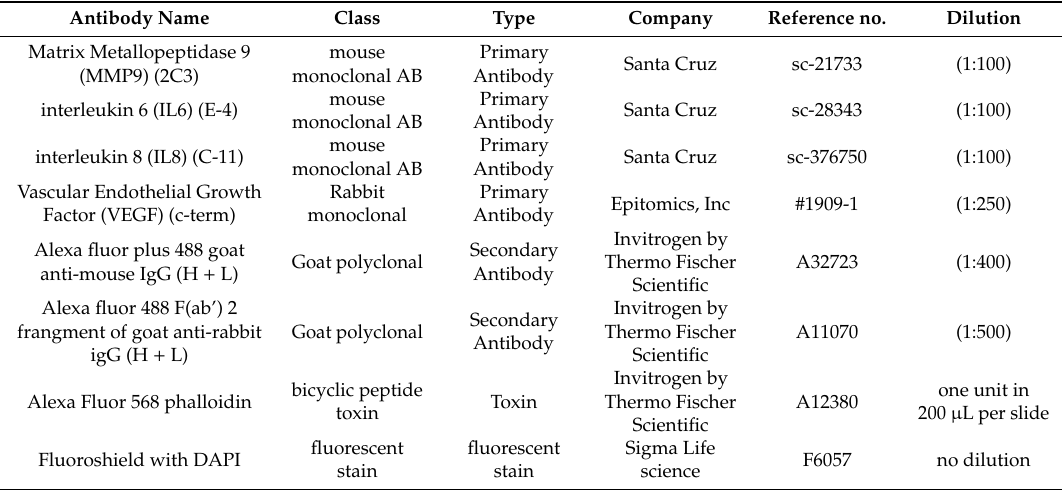
Table 1. Names, types, classes, companies, and dilutions of all the antibodies that were used for